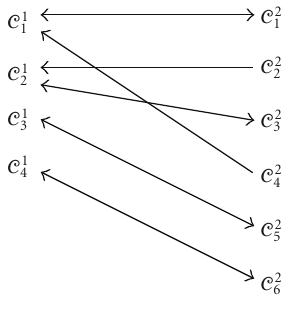
Figure 2: The correspondence between the clusters of the two results from Figure 1 using the intercluster similarity by